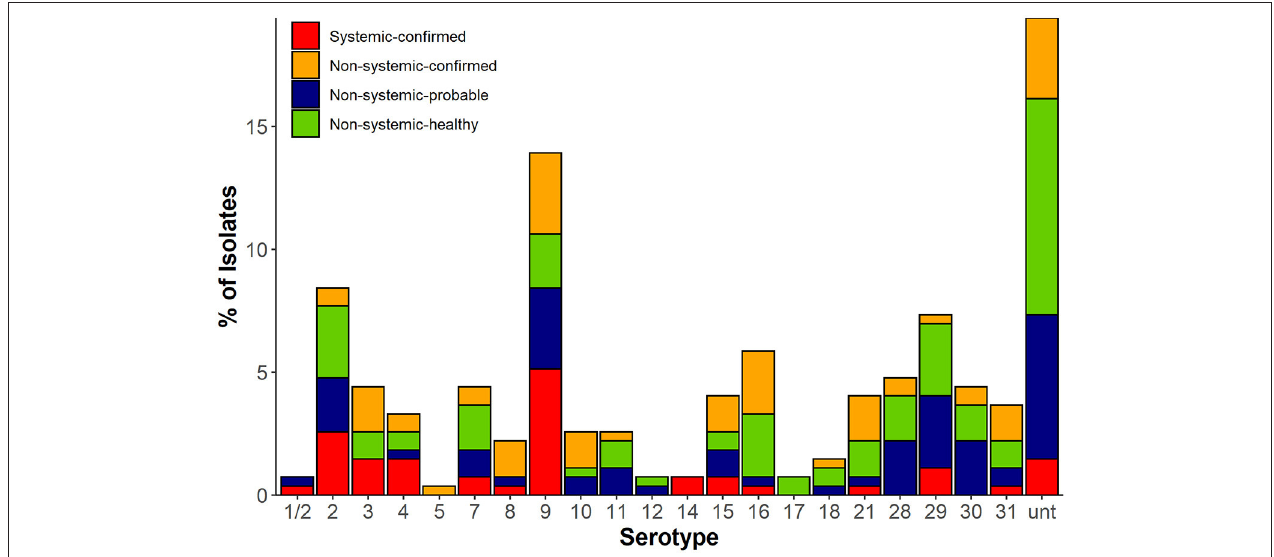
FIGURE 1 | In silico serotype of 273 S. suis isolates in four classified groups based on disease status (confirmed, probable infection, and healthy) and isolation source. Systemic sites included blood, meninges, spleen, and lymph node. Non-systemic sites included tonsil, nasal cavities, ileum, and rectal sample.